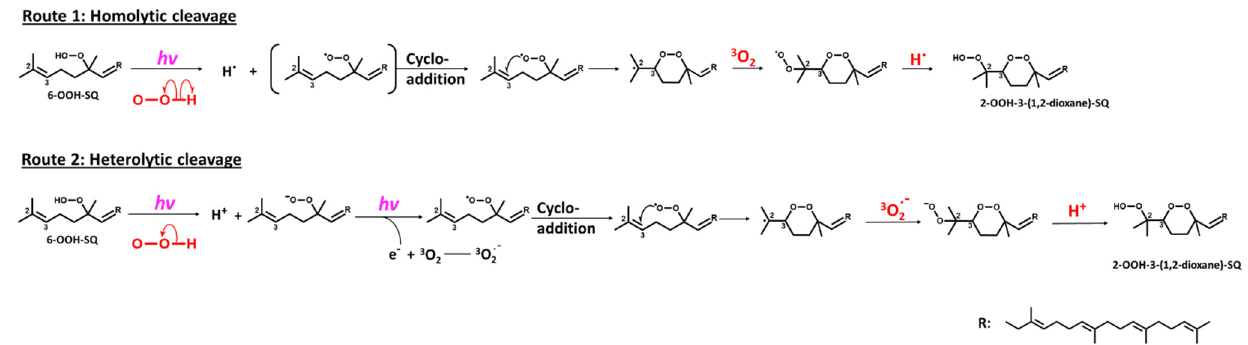
Figure 6. Proposed mechanism involved in the formation of 2 ‐ OOH ‐ 3 ‐ (1,2 ‐ dioxane) ‐ SQ from 6 ‐ OOH ‐ SQ following two possible routes.